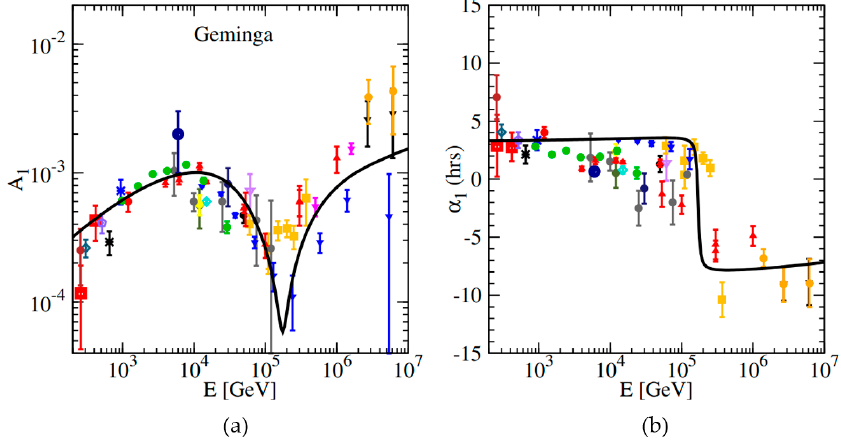
Figure 4. The amplitude ( a ) and phase ( b ) of the dipole anisotropy with the contribution from the nearby Geminga SNR source. The data points are taken from underground muon detectors: Nori-